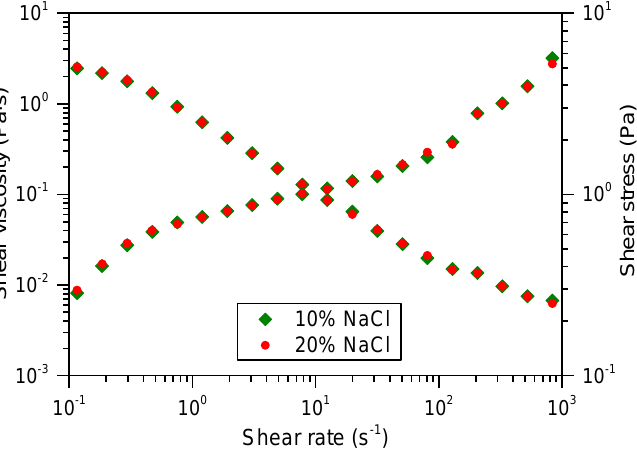
Figure 6. Shear viscosity of ( a ) HPAM and ( b ) biopolymer solution at various NaCl content.